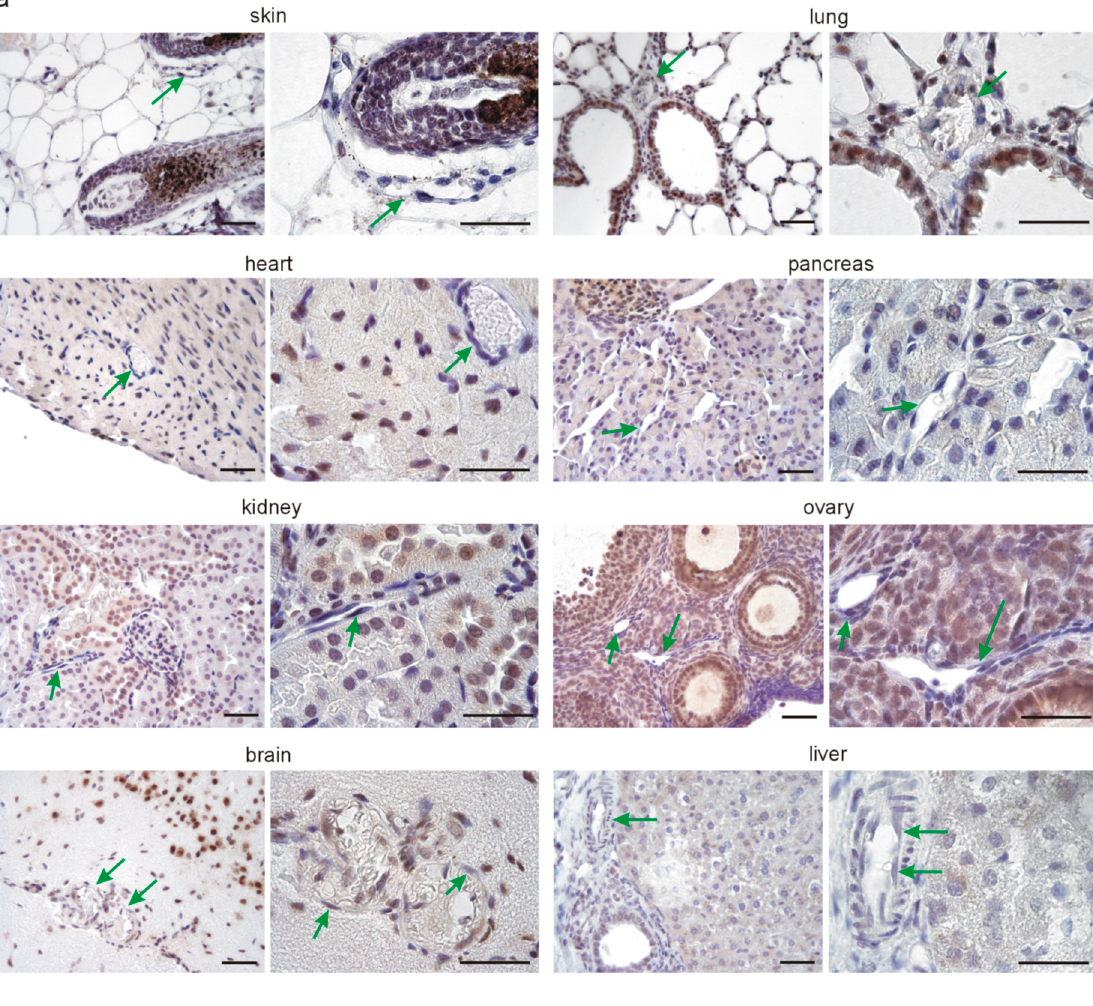
Figure 2. Srsf1 expression in different healthy adult mouse tissues and different human tumor types. ( a ) Representative examples of Srsf1 immunostaining (DAB substrate, brown) in skin, lung, heart, pancreas, kidney, ovary, brain, and liver sections of adult mice ( n = 3 each). Nuclei were counterstained with hematoxylin (blue). For each organ, one example and a higher magnification are shown. Note the nuclear localization of Srsf1 in different cell types of the organs. Green arrows point to vascular endothelial cells in the different organs, which are rarely Srsf1-positive. ( b ) Representative